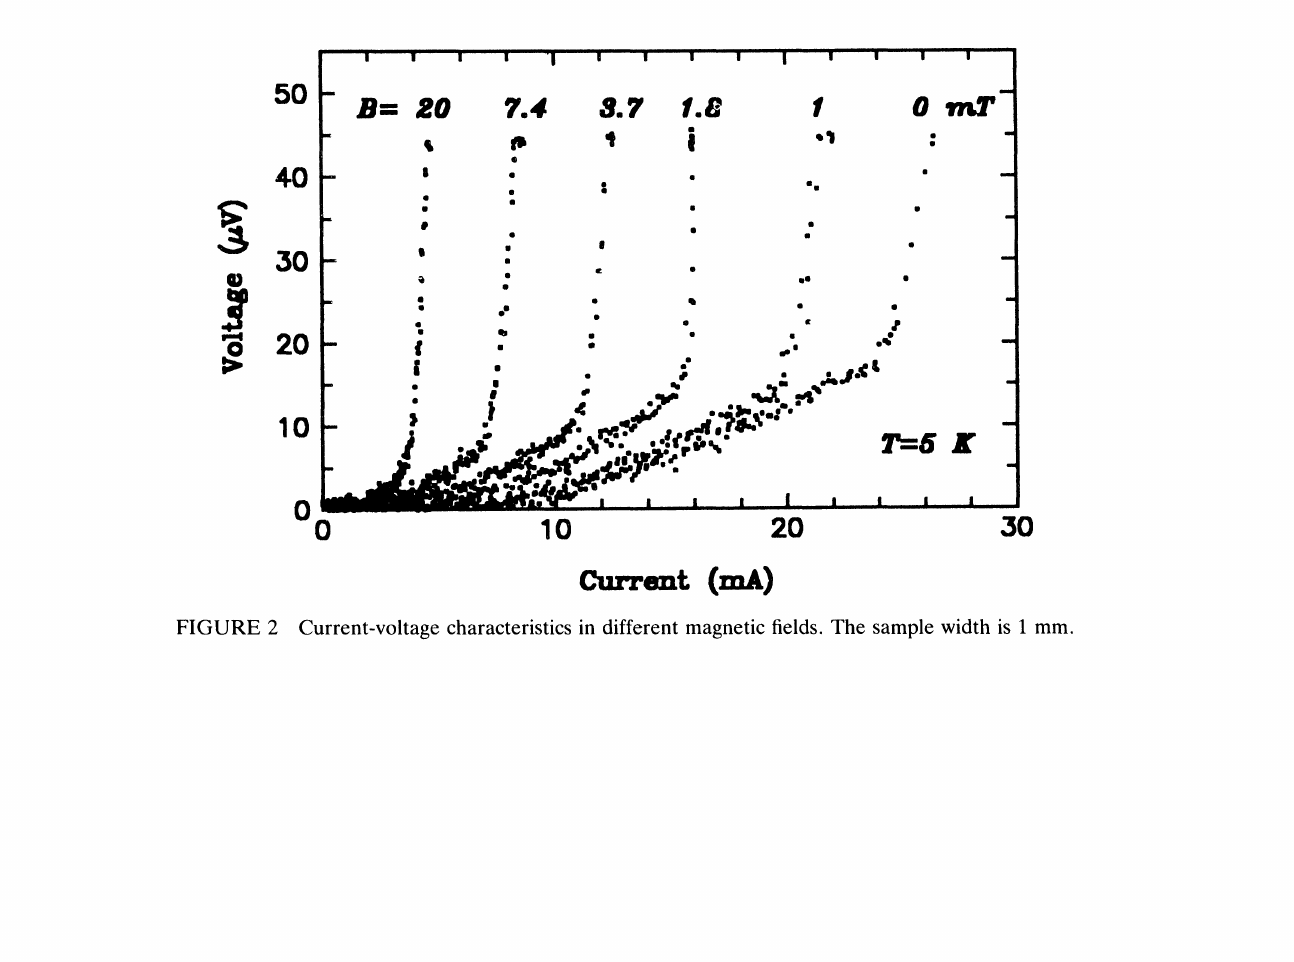
Resistance-temperature characteristics of the two types of samples used in our measure- ments. The 2212 sample is a single phase one while the 2223 is mixed.